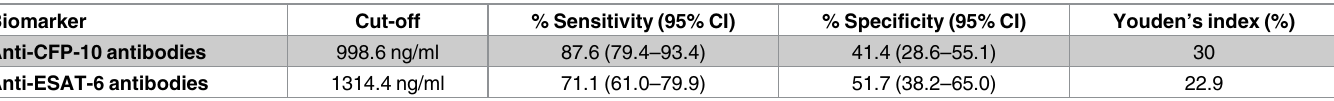
Table 2. Potential of anti-CFP-10, anti-ESAT-6 antibodies to differentiate active and latent TB